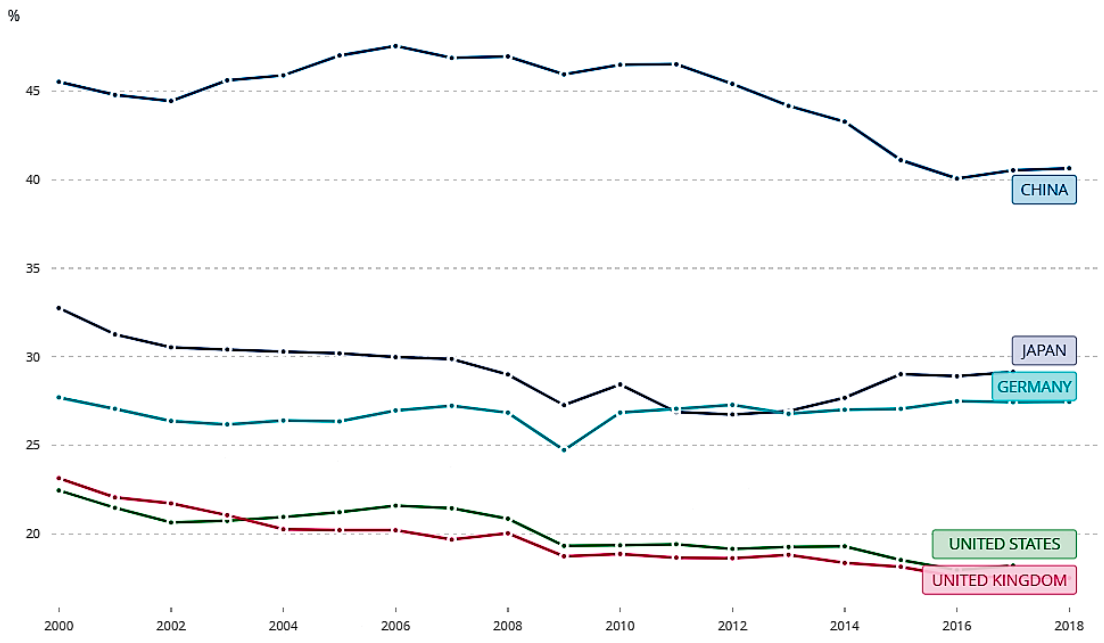
Figure 1. The percentage of industrial (including construction) added value in GDP (data source: World Bank).